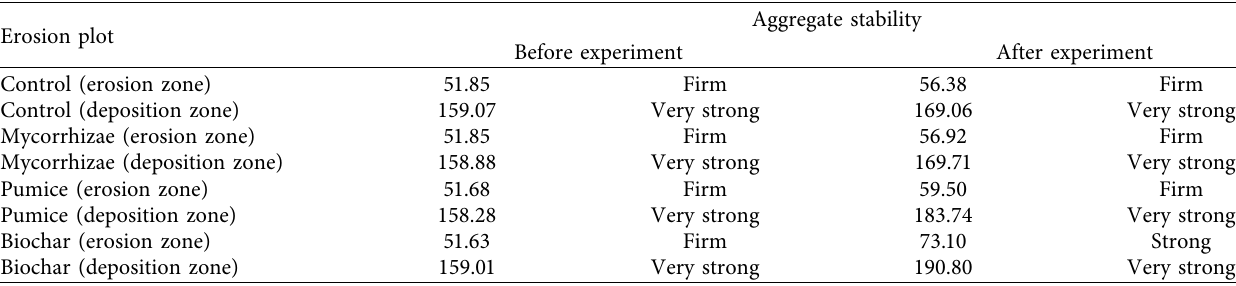
Figure 5: SEM test results of bamboo leaf biochar and pumice stone. (a) Biochar. (b) Pumice. Table 6: Changes in aggregate stability values after